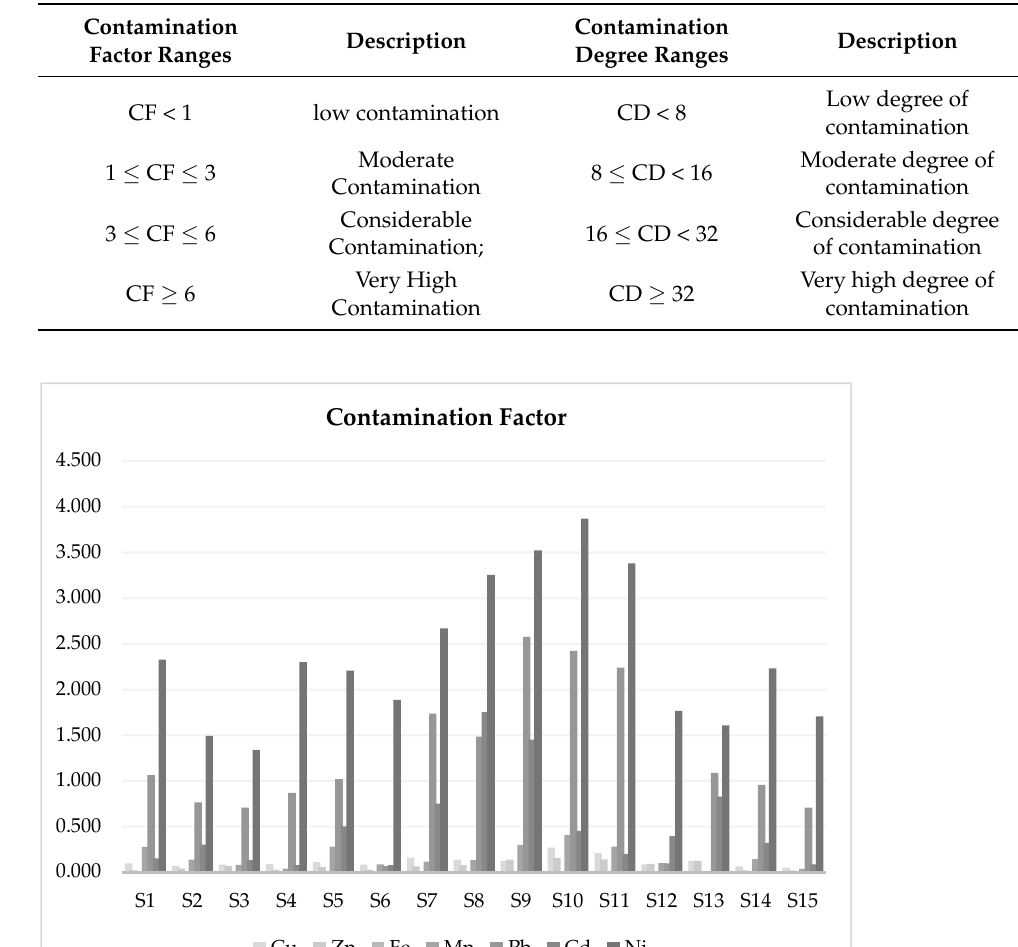
Table 3. Description of Contamination Factor (CF) and Contamination Degree (CD) according to [38].